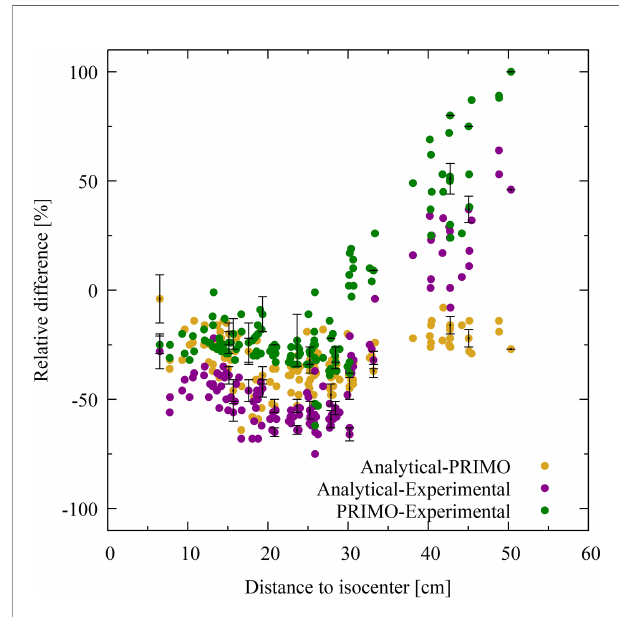
FIGURE 5 | Dose difference for volumetric modulated arc therapy in percentage for each thermoluminescent dosimeter (TLD) position given with respect to the distance to the isocenter. The difference between PRIMO and analytical data is represented with brown dots, and the PRIMO data set is taken as the reference. The comparison between experimental and analytical data is shown with purple dots and between experimental and PRIMO data with green dots. In these cases, the experimental data is taken as the reference data set. For visual clarity, statistical uncertainty bars ( k = 2) are shown for every twentieth TLD